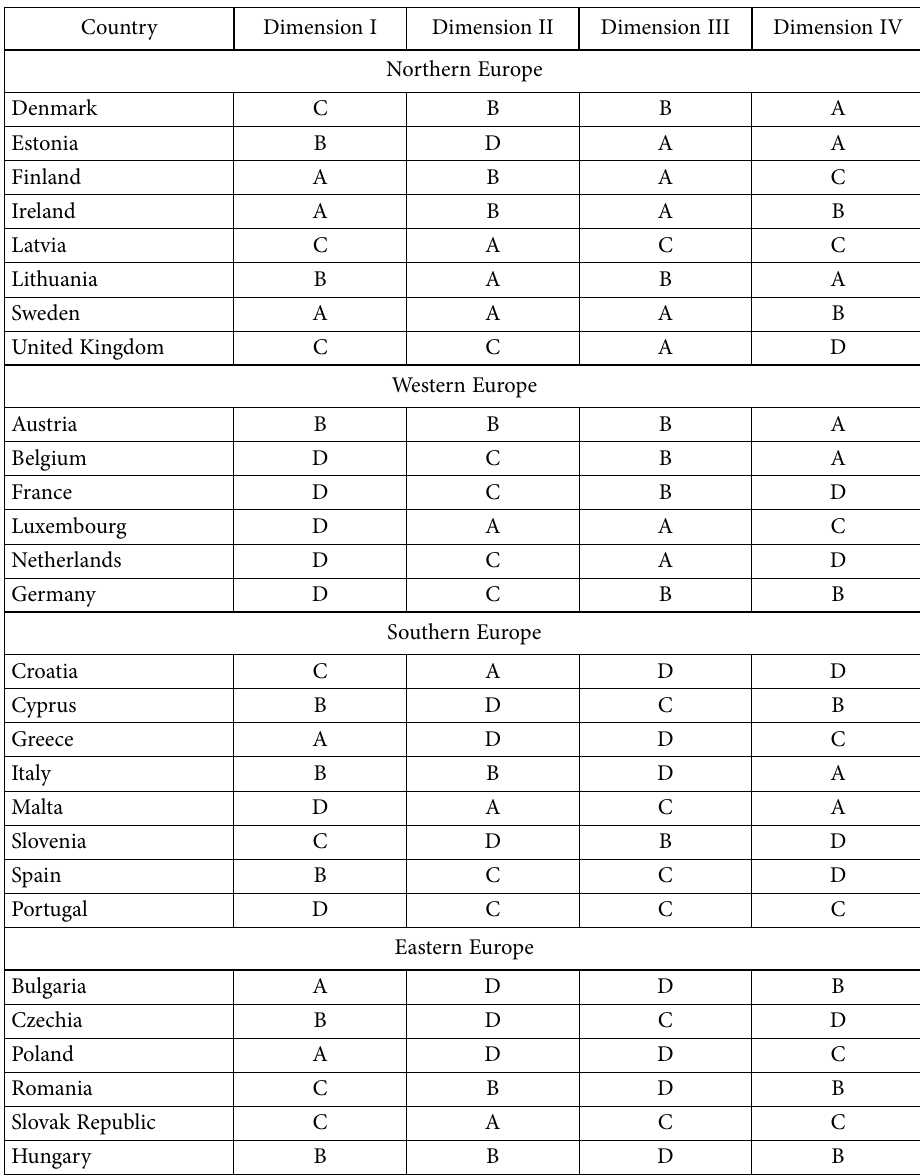
Table 9. The results of division of EU countries into typological classes Country Dimension I Dimension